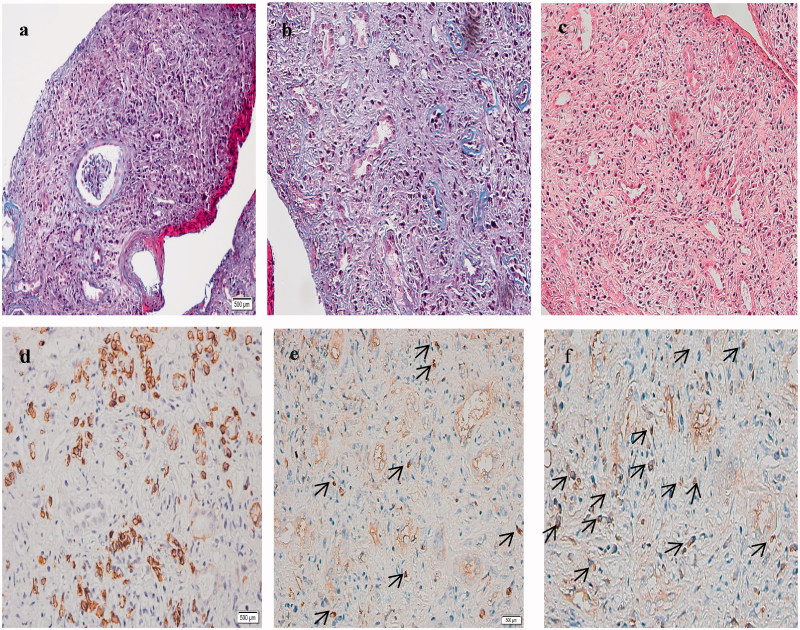
Pathological features of the renal biopsy specimen. (a) The tubulointerstitium shows marked injury, but the glomerulus shows no specific features (Masson trichrome staining, ×100). (b) Storiform fibrosis with tubular atrophy can be observed in the tubulointerstitium (Masson trichrome staining, × 200). (c) A mass of inflammatory cells, including lymphocytes and plasma cells, are seen infiltrating the interstitium (hematoxylin-eosin staining, ×200). (d) Immunohistochemical staining shows mostly CD138-positive plasma cells in the interstitium. (e, f) Immunohistochemical staining shows seven and thirteen IgG4+ and IgG + plasma cells in the same area of serial sections, respectively (Figures 1(e,f)) (indicated by the arrows). So the IgG4+/IgG + plasma cells ratio is calculated to be 53%.